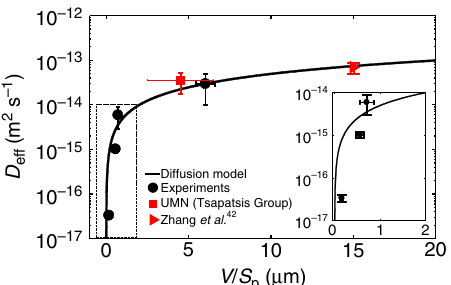
Figure 5 | Surface effects on water diffusion. Diffusion coefficients of water in MFI zeolites from experiments (dots) and model (triangles) with increasing concentration of hydrophilic defects. Self-diffusivity ( D , red triangles) is obtained from MD simulations, averaged in the adsorption range and rescaled by the experimental self-diffusivity of bulk water at 300K (see Supplementary Fig. 9). Corrected diffusivities are obtained by either considering the effect of surface barriers on MD results by equation (4) ( ð G þ 1 Þ (cid:2) 1 , blue triangles, where a ¼ 5.0 (cid:3) 10 (cid:2) 9 ms (cid:2) 1 is D a V S p assumed as constant and equal to the experimental value found for silicalite-1) or by experiments ( D eff / G , black dots; see Fig. 4 and Supplementary Fig. 2 in ref.